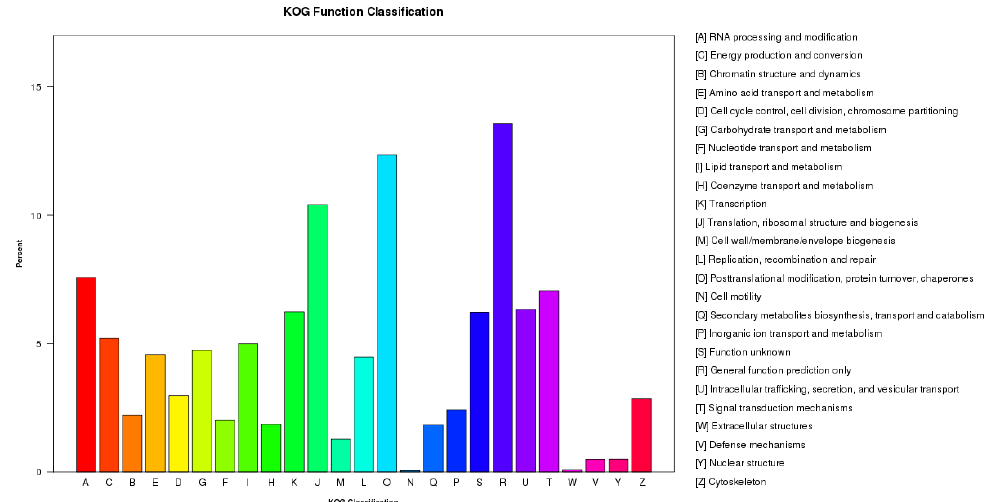
Figure 2. EuKaryotic Orthologous Groups (KOG) annotation of putative proteins. The x ‐ axis indicates the names of the 25 groups of KOG. The y ‐ axis indicates the percentage of the number of genes annotated to the group out of the total number of genes annotated.